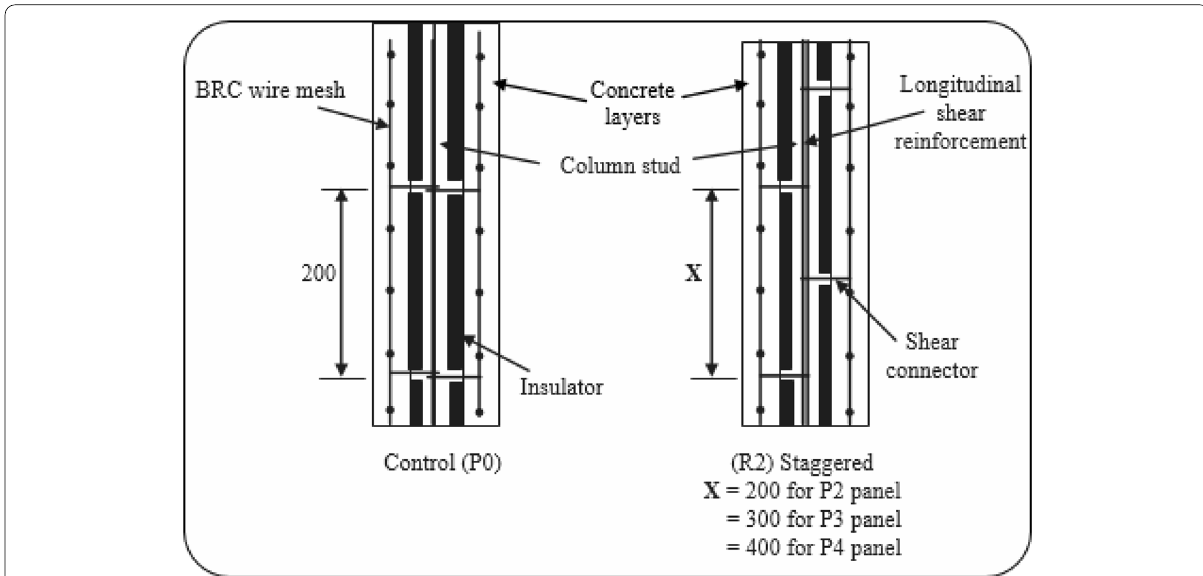
Fig. 2 Section details through the column stud of the